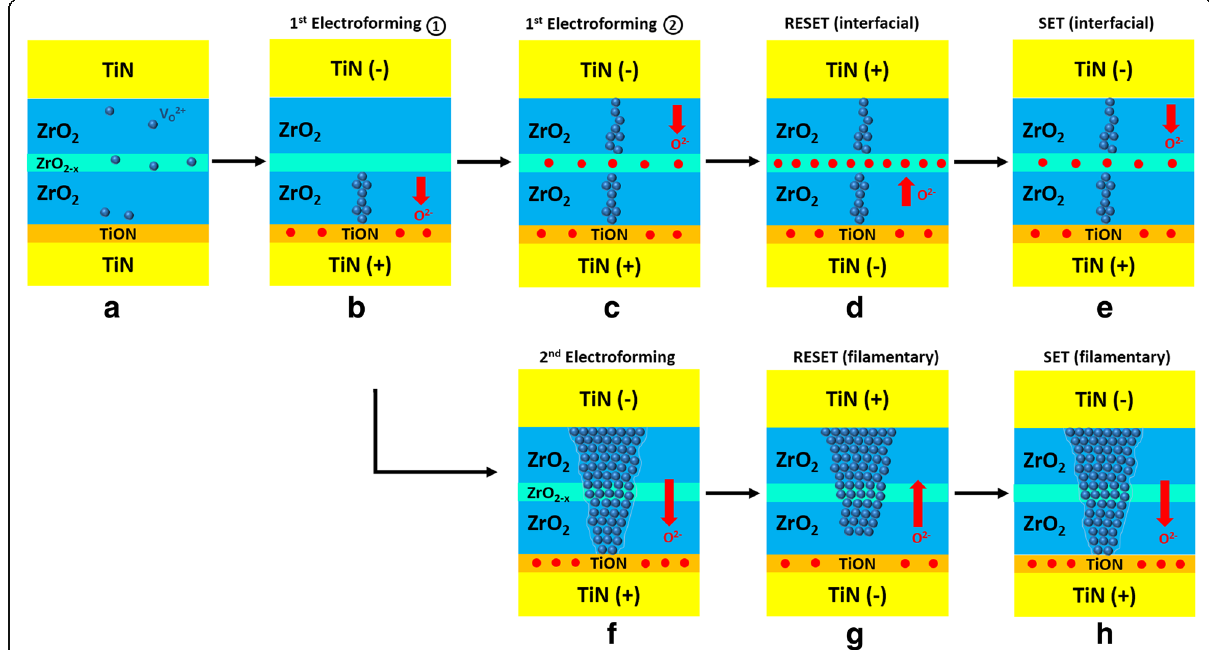
Fig. 7 Schematics of the switching mechanism on the tri-layer TiN/ZrO 2 /ZrO 2 − x /ZrO 2 /TiN device for the interfacial switching mode ( a – e ). The transformation from interfacial mode to filamentary mode ( f ) and the filamentary mode ( g , h